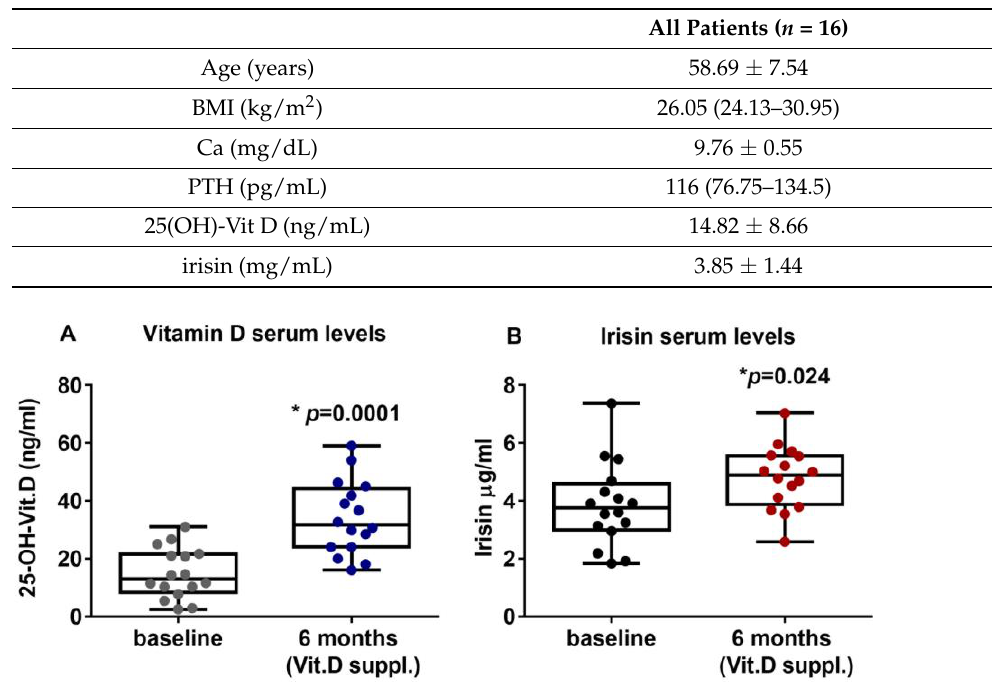
Table 1. Mean ( ± SD) or median (25%; 75%) for all variables.